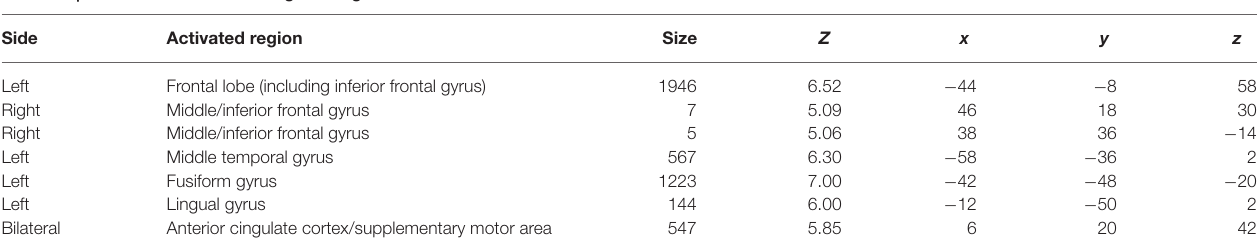
TABLE 1 | Cortical activation during